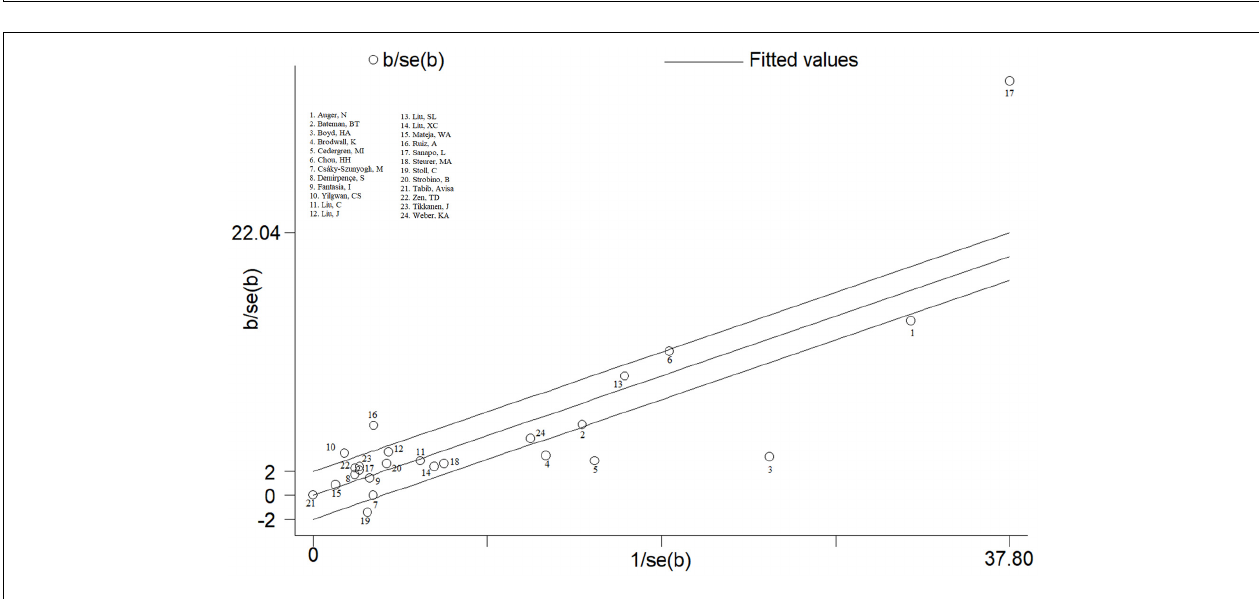
FIGURE 5 | Sensitivity analysis for the association of maternal HDP exposure with risk of overall CHDs in offspring.